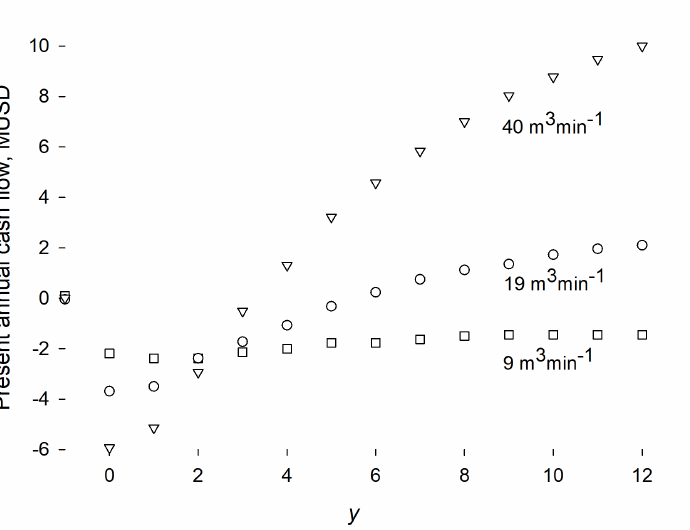
Figure 4. The MRU is uneconomical for battery units that flare less than 10m 3 min − 1 of natural gas. Here, the FT fuel is sold at the same price as raw oil and the natural gas cost is 0USDm − 3 (scenario 2–2).